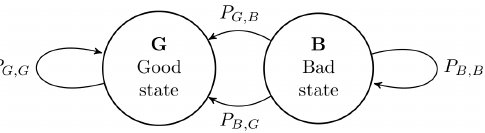
Figure 4. First order Markov chain illustrating the channel model developed by Lutz